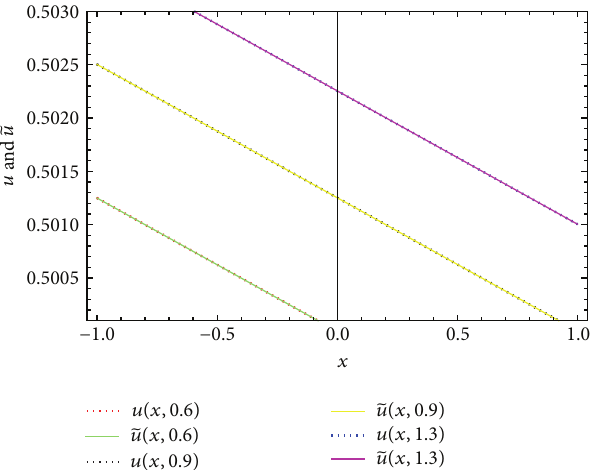
Figure 12: The approximate and exact solutions for different values of 𝑡 (0, 0.5 and 0.9) of problem (44) where 𝛼 = 𝛽 = 1/2 and ] = 𝛾 = 10 −2 at 𝑁 = 20